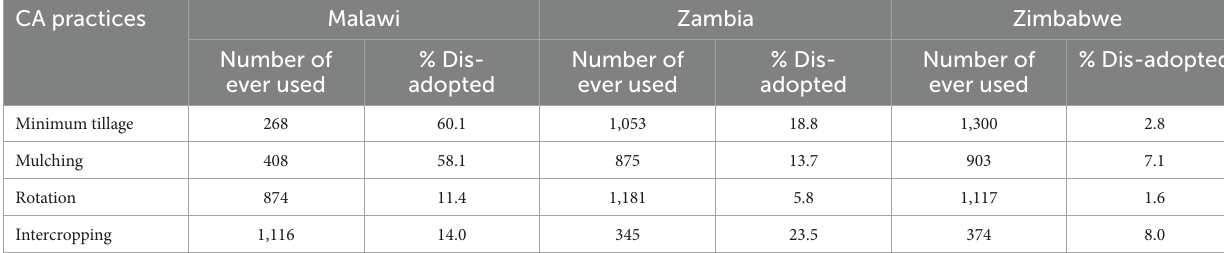
TABLE 10 Dis-adoption of CA components by country (percent of